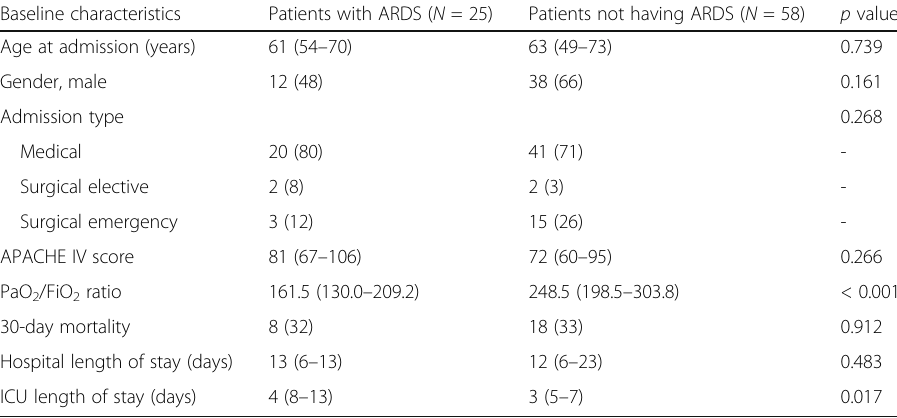
Table 1 Baseline characteristics of included patients on admission Baseline